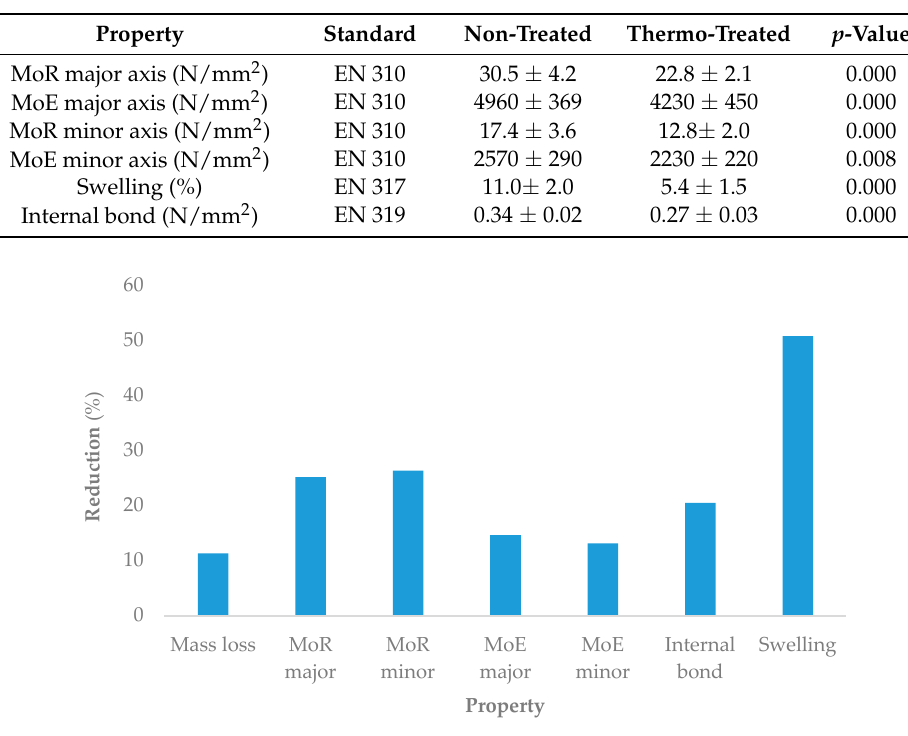
Figure 2. Percentage reduction of the properties of treated specimens referred to non-treated test specimens.